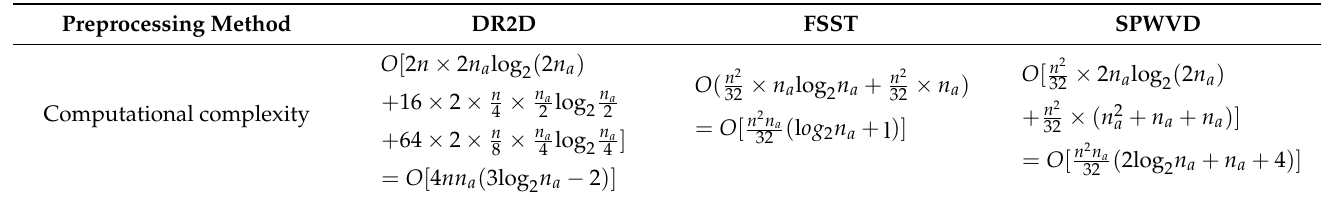
Table 1. Computational complexities of the DR2D, FSST and SPWVD preprocessing methods. Preprocessing Method